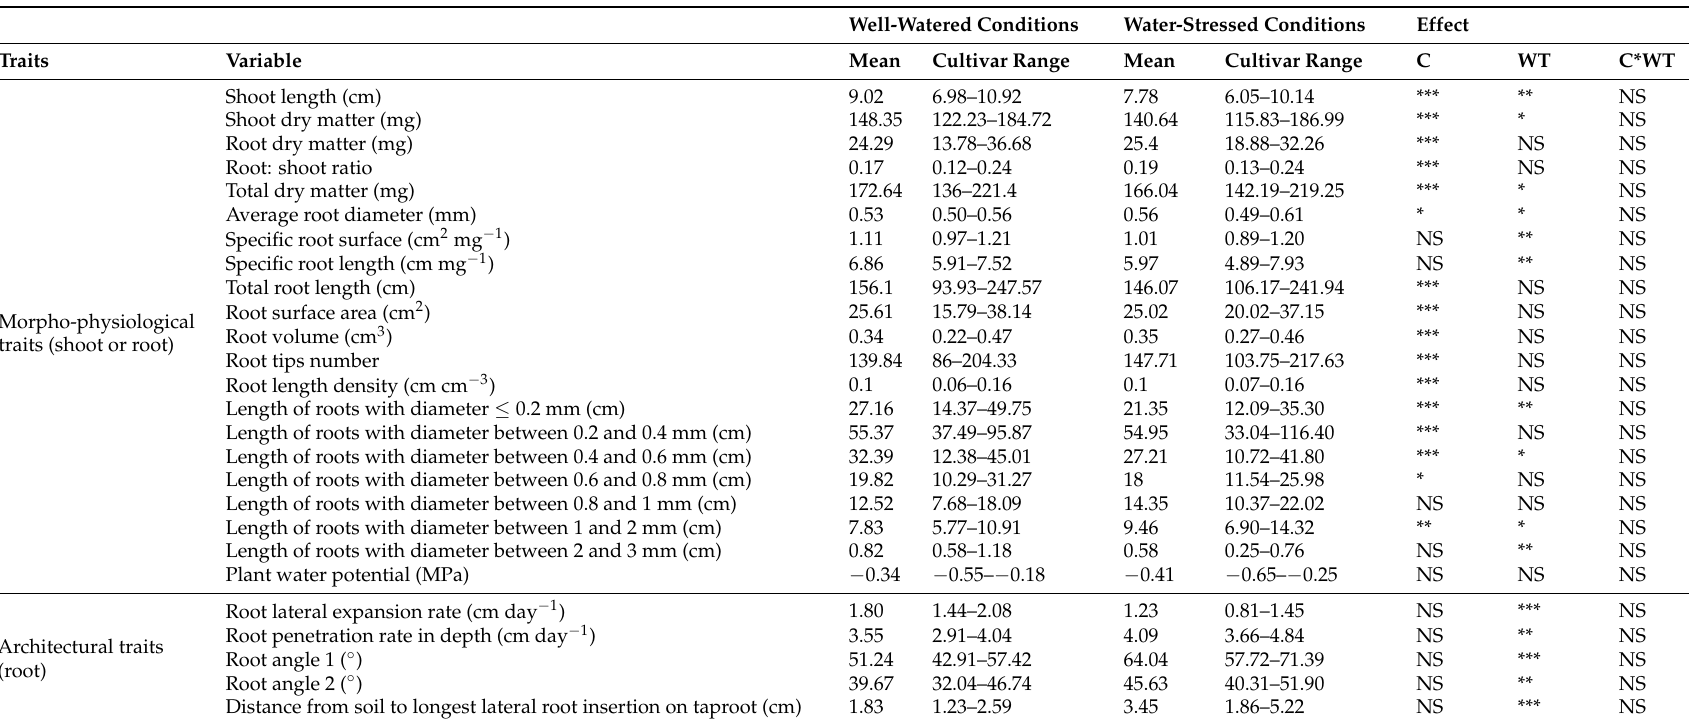
Table 3. Means and cultivar range of studied variables and the impact of cultivars (C), soil moisture status (WT) and the interaction between C and WT on each